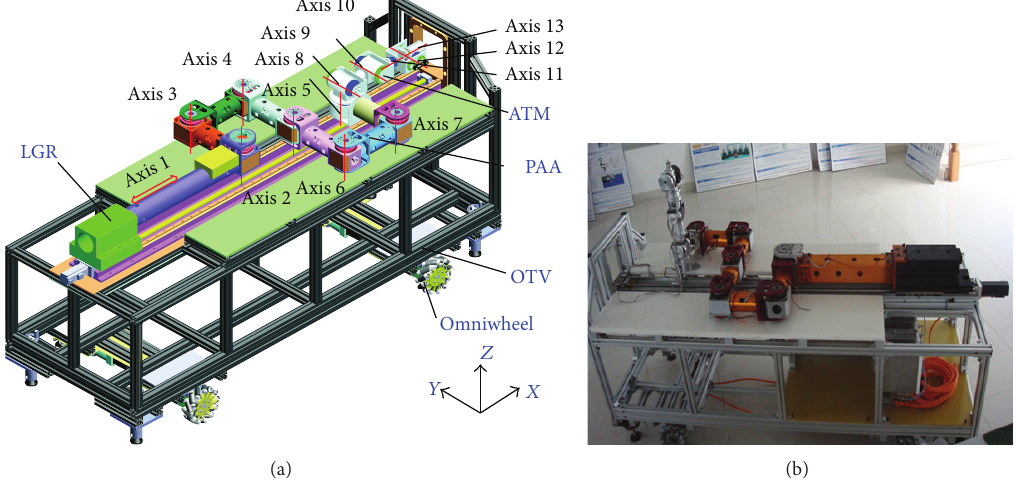
Figure 2: The CAD view of RHR (a) and the actual RHR